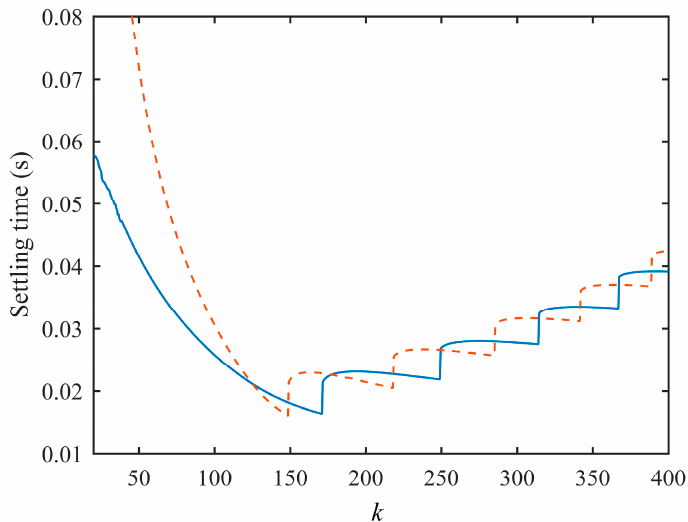
Figure 14. The settling time of the proposed PLL with different values of k under. phase jump (solid line) and frequency step ‐ change (dashed line) conditions.